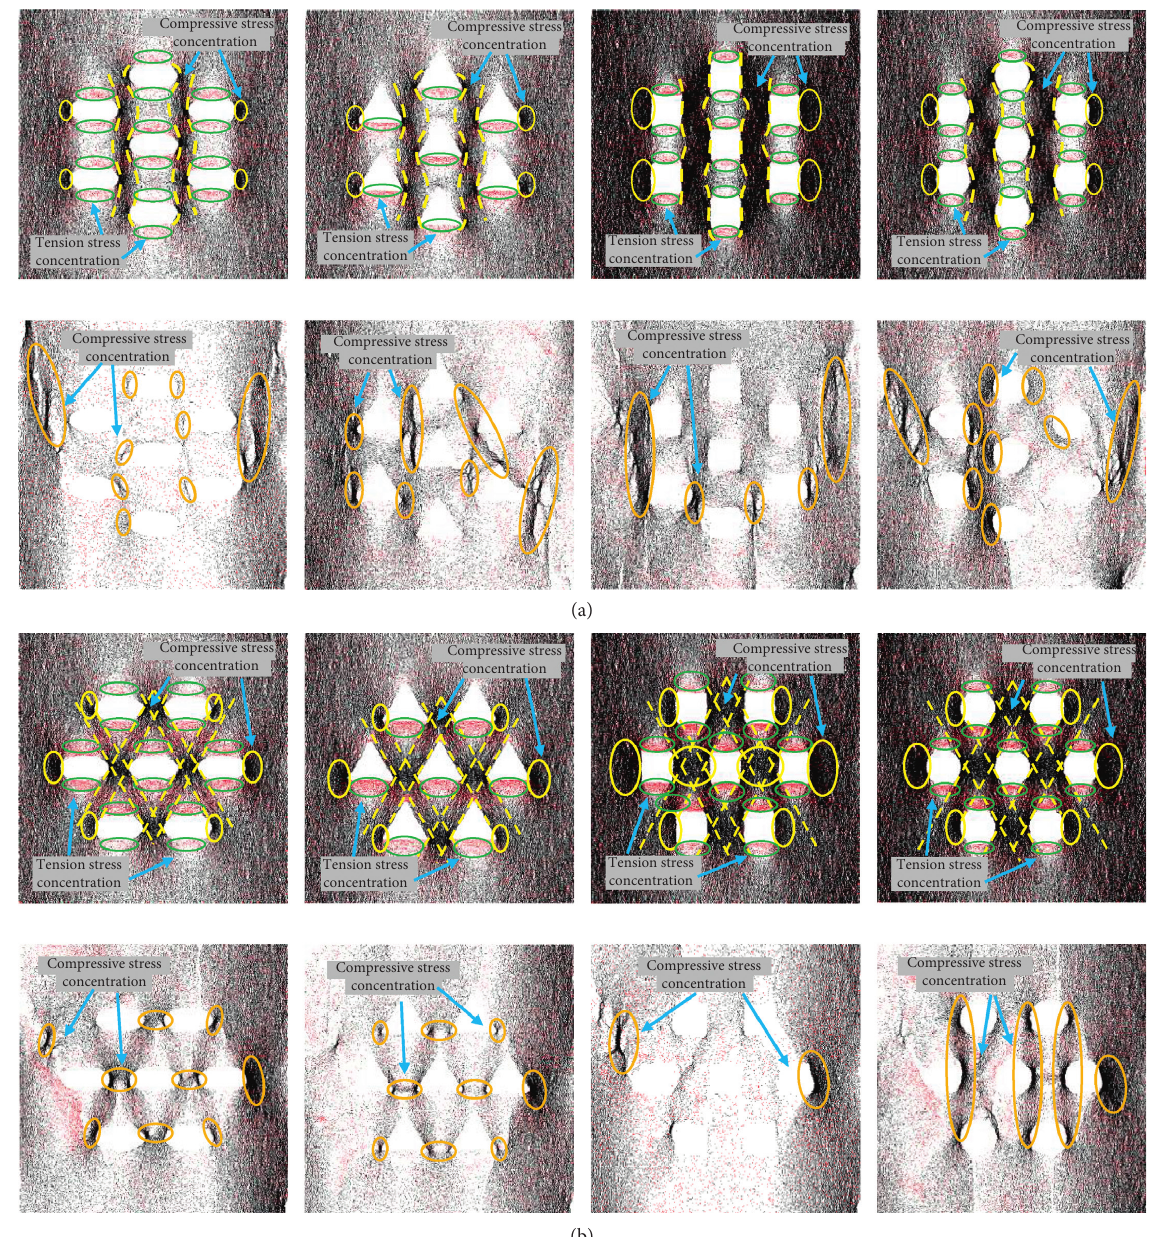
Figure 10: Distribution of contact forces before crack formation and after crack failure in vertical and horizontal orientation models (the black lines represent compressive stress. The red lines represent tensile stress. The dense and sparse lines represent the magnitude of stress. The yellow ellipse and yellow curve marked areas are compressive stress concentration areas, and the green ellipse marked areas are tensile stress concentration areas). (a) Contact force before crack formation and after crack failure of the vertical orientation model. (b) Contact force before crack formation and after crack failure of the horizontal orientation